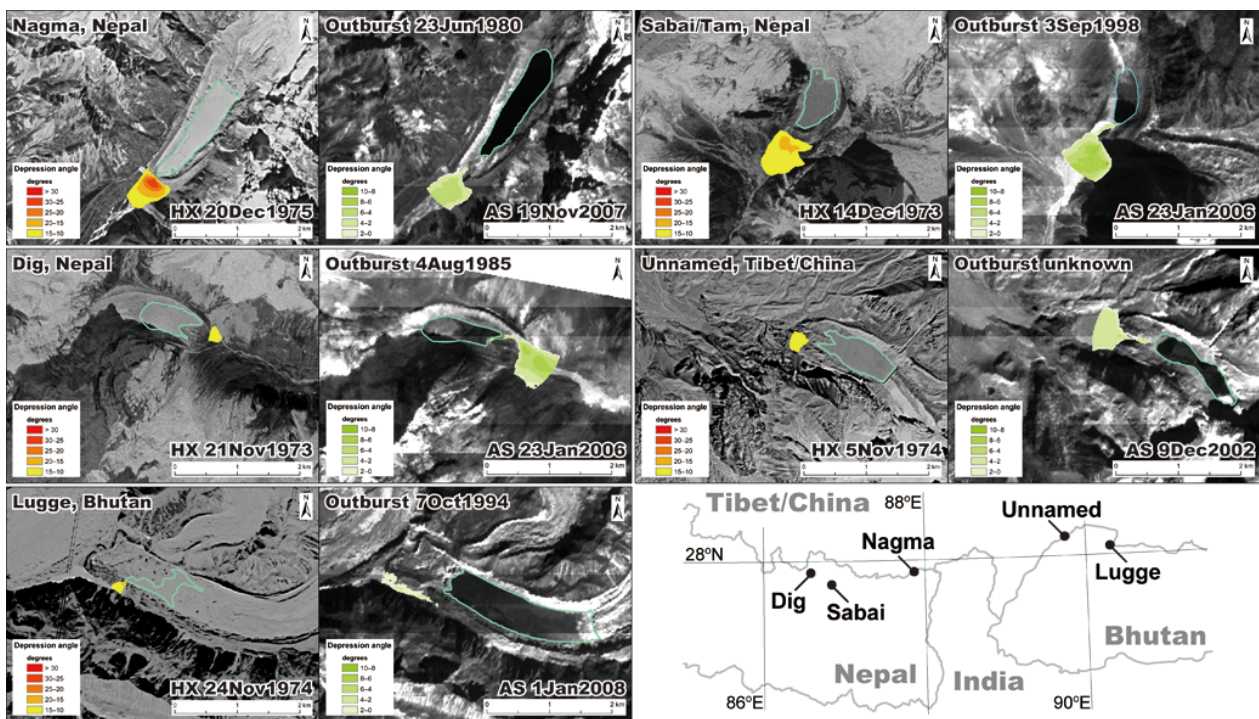
Fig. 5. Pre- (HX) and post-GLOF (AS) images of the five lakes showing changes in depression angle (details in Table 1). Acquisition dates area indicated after HX (Hexagon) and AS (ASTER).